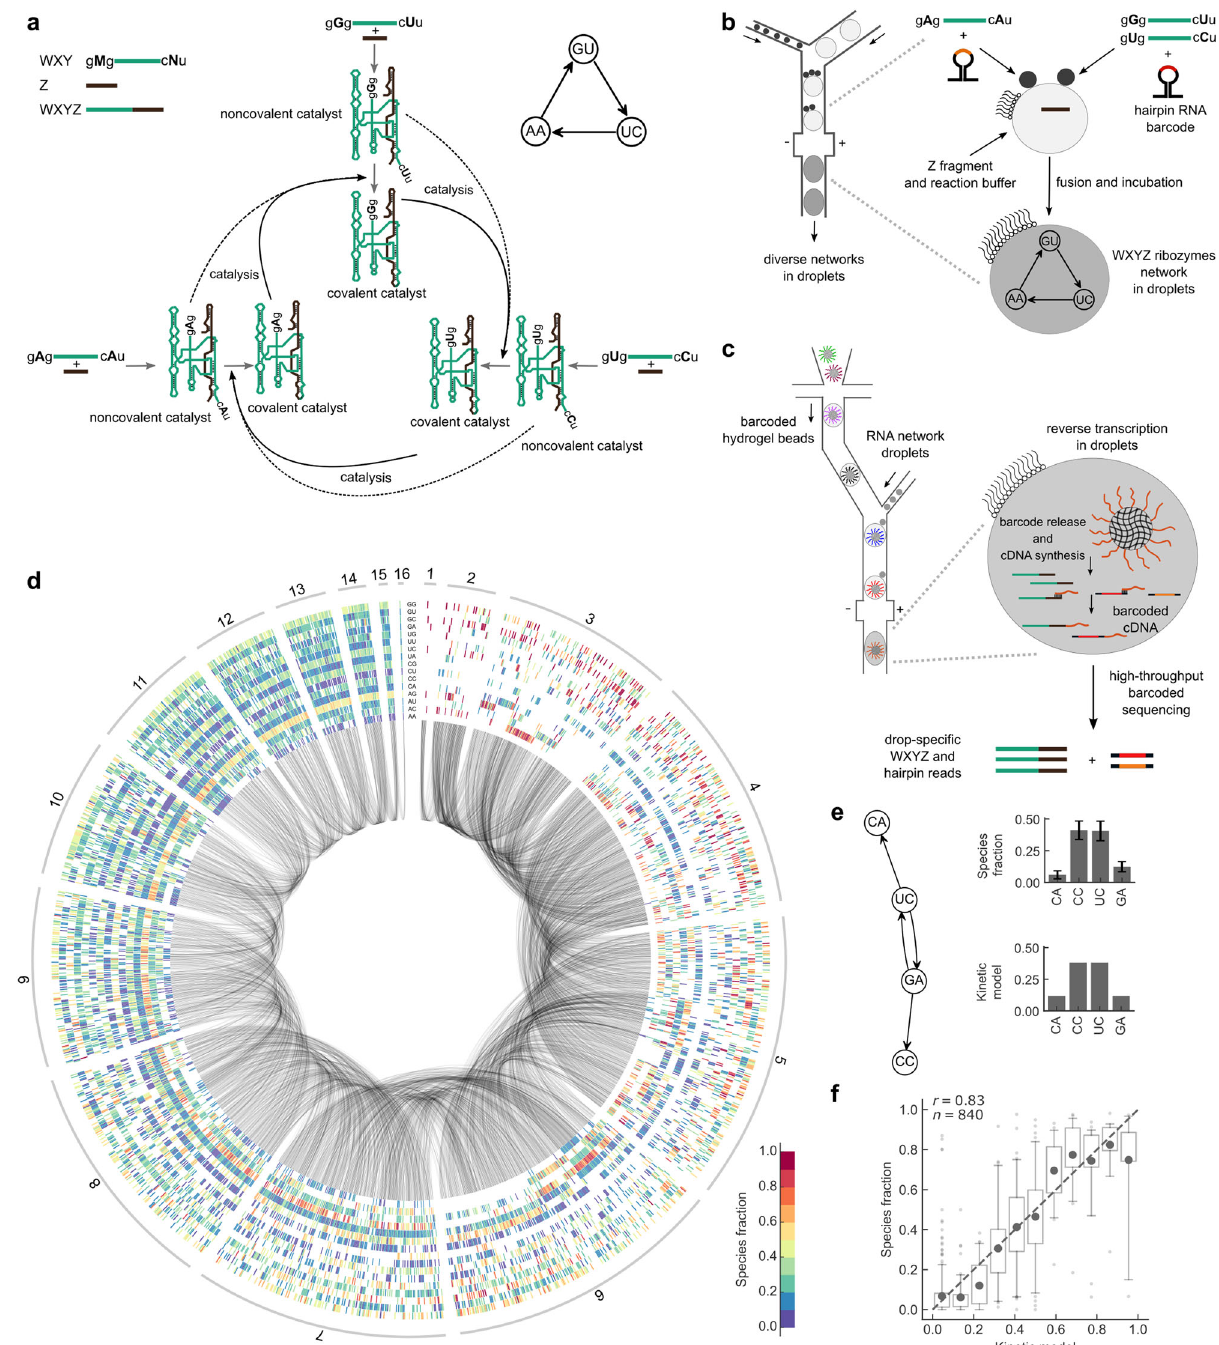
approximations of early reaction times and weak consumption of noncovalent complexes